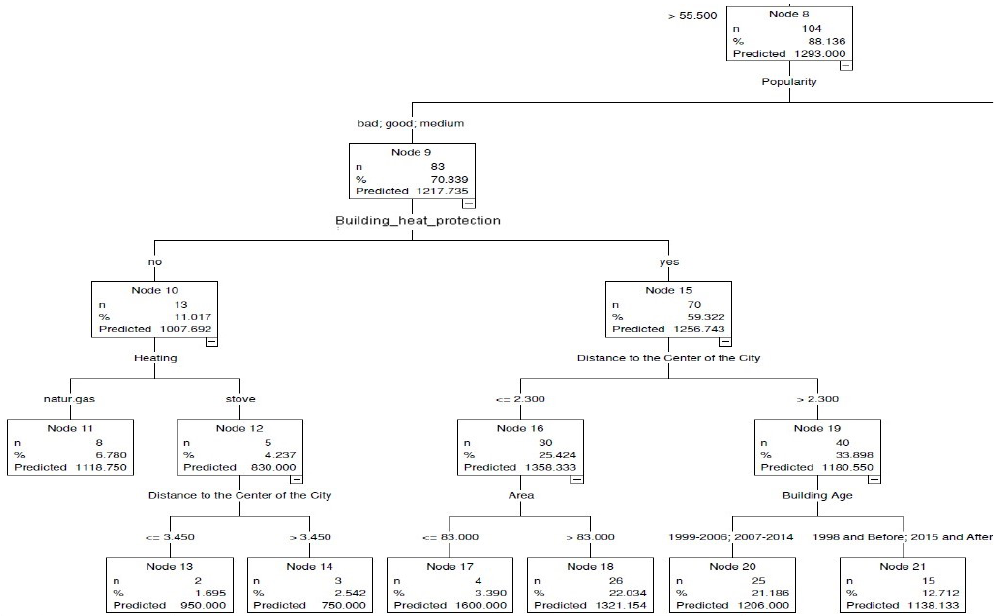
Fig. 9. Decision tree node 9 and the estimated real estate unit value (developed by the